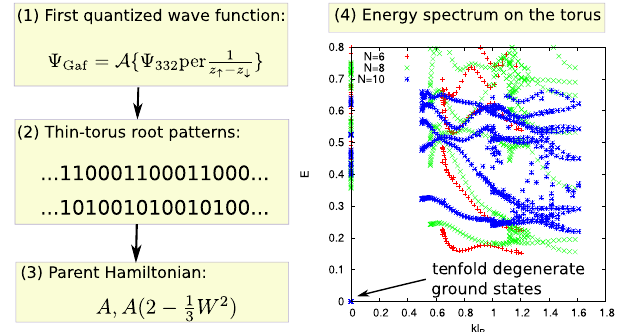
FIG. 6. Main steps in constructing the fermionic Gaffnian parent Hamiltonian. (i) Assume the first quantized wave func- tion, in this example given by Eq. (40). (ii) Find the cor- responding thin-torus root patterns (here, 1100011000 … and 1010010100 … ). (iii) Construct the parent Hamiltonian by con- sulting Eq. (26) and Table III. (iv) Verify the construction and compute properties by exact diagonalization. Here, this is performed on a hexagonal torus with N ¼ 6 ; 8 ; 10 particles, finding a tenfold ground state with exactly zero energy. The energy scale is set by γ ¼ 1 in Eq. (43). As the torus is stretched along one direction, the ground states evolve to the expected patterns 1100011000 … and 1010010100 … . In addition, we obtain the entire low-lying neutral excitation spectrum, allowing one, in principle, to extract many other properties of the